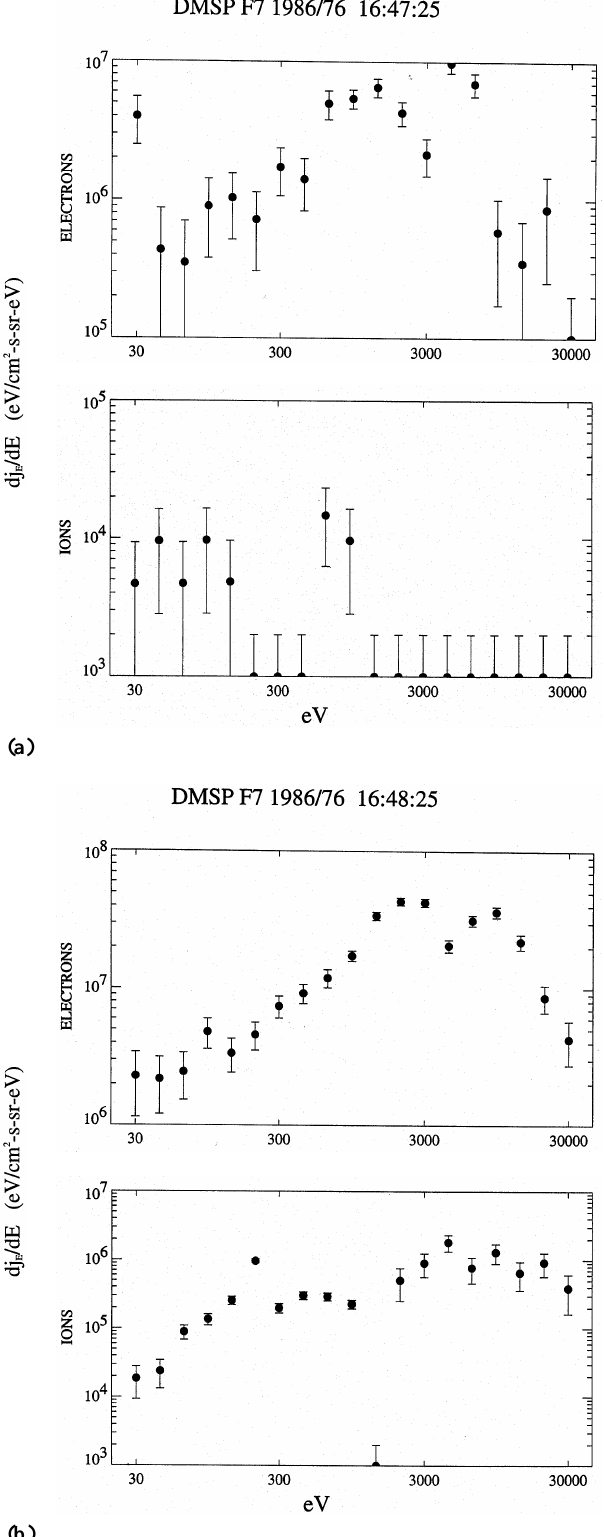
Fig. 3a-b. Electron and ion spectra observed at low altitude by DMSP F7 for the pass shown in Fig. 1. Plotted is the differen- tial energy flux (circles with error bars) for various plasma regimes: (a) DAZ; (b)